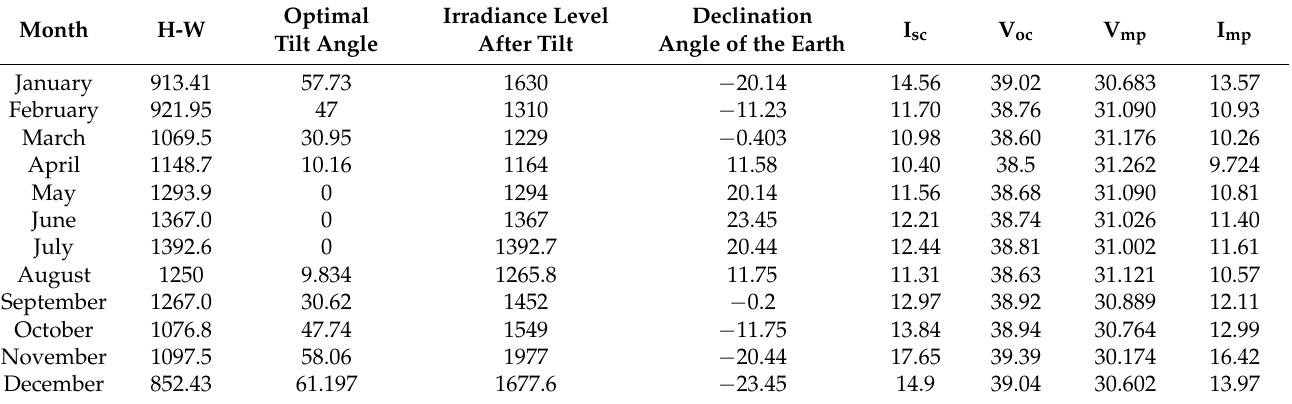
Table 3. Monthly specific daily global irradiance (H), optimal tilt angle (deg), declination angle of